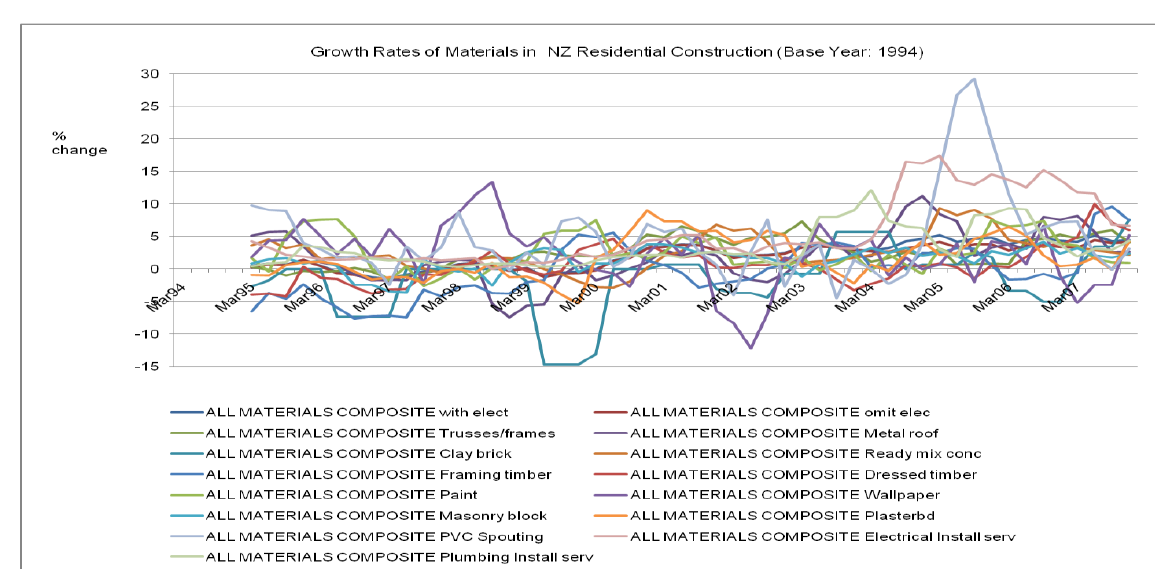
Figure 11 Growth Rates of Material Price Index (All